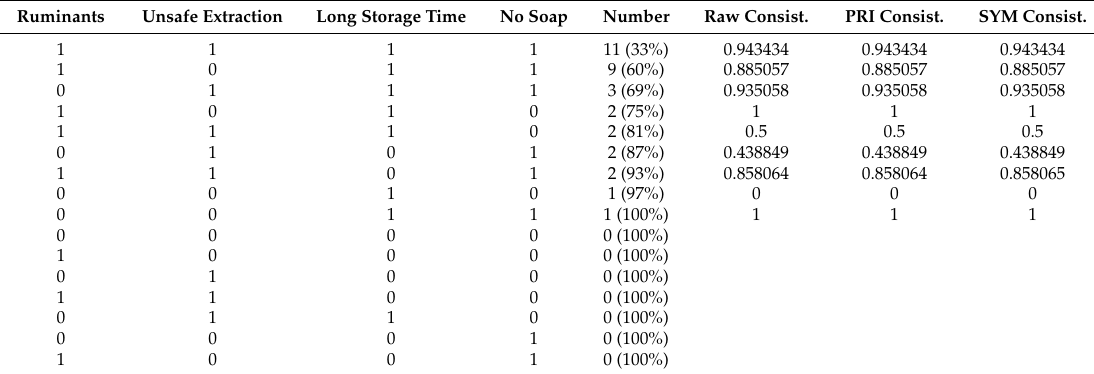
Table A1. Truth table showing the number of households who have various combinations of the causal conditions chosen.